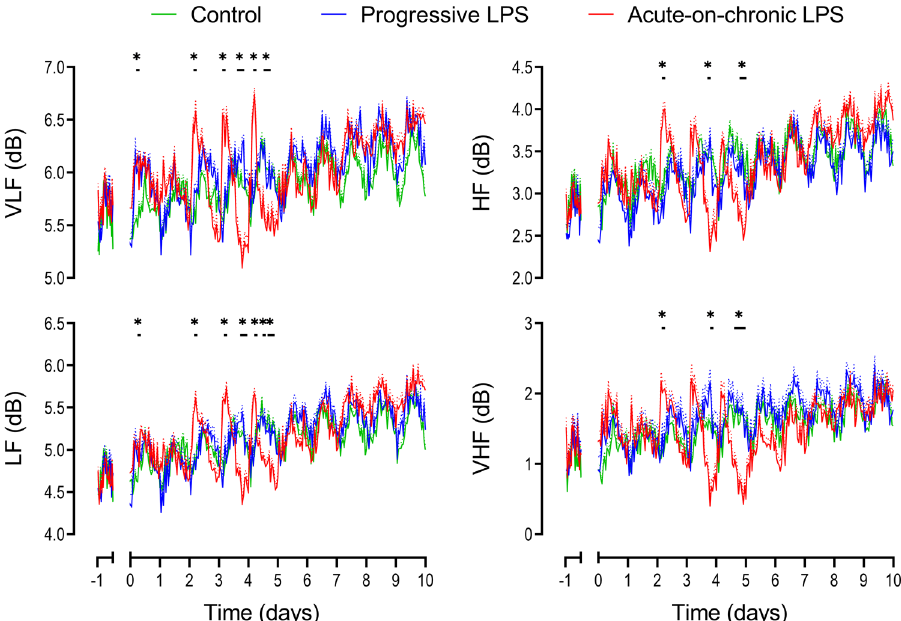
Figure 5. Changes in frequency domain measures during and after LPS infusions. Frequencies presented include very low frequency (VLF, 0.0033–0.04 Hz), low frequency (LF, 0.04–0.15 Hz), high frequency (HF, 0.15–0.4 Hz) and very high frequency activity (VHF, 0.4–1.5 Hz). All measures were natural log transformed for presentation. All LPS infusions were started on day 0 and continued for a total of 5 days, fetuses were studied for a further 5 days after the end of infusions. Groups shown are control (green, n = 10), progressive LPS (blue, n = 8) and acute-on-chronic LPS (red, n = 9). Data are shown as 1 h mean ± SEM (mean is displayed as solid lines, SEM is displayed as dotted lines). *P < 0.05 control vs. acute-on-chronic